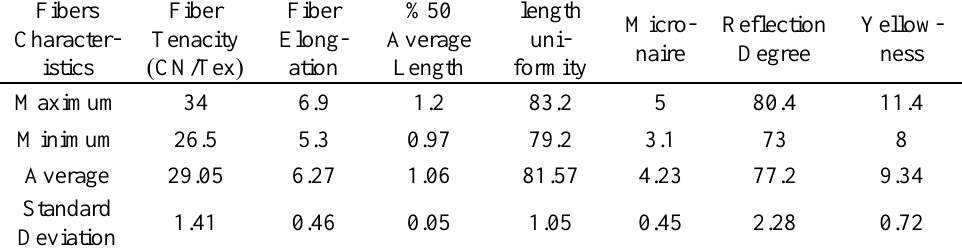
Table 2. Statistical summary of data for fiber properties